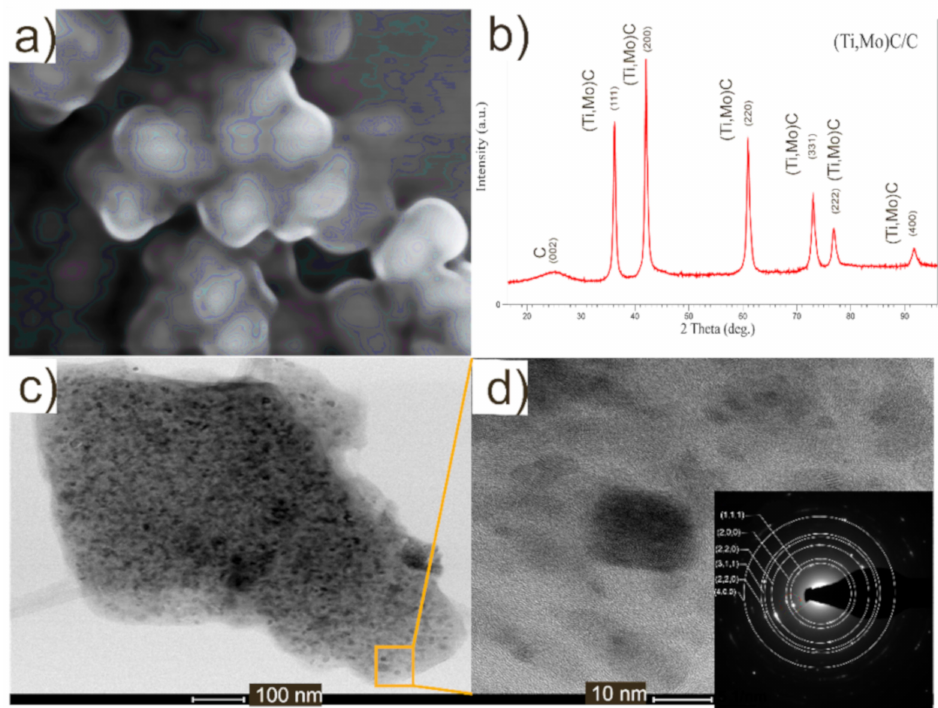
Figure 1. Morphology of the starting material: ( a ) SEM micrograph; ( b ) XRD diffraction pattern; ( c ) and ( d ) TEM micrograph of nc-(Ti,Mo)C/C crystals in carbon shell and corresponding SAED